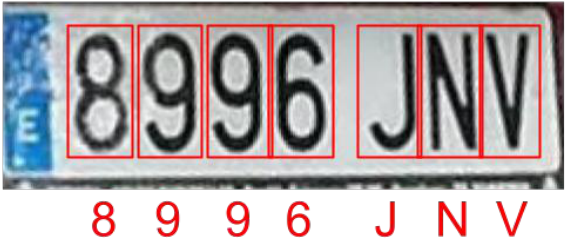
Figure 11. Character